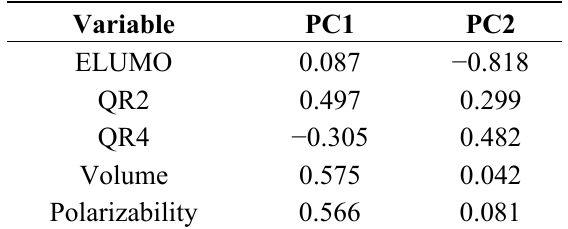
Table 2. Loading values of the selected